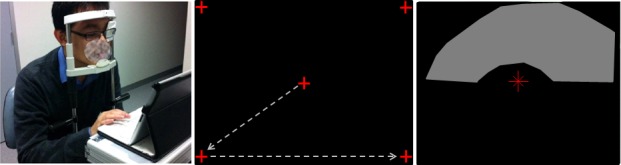
MRF performance was tested in five young participants who had normal vision. (A) The test site with chin and forehead rest and the observer fixating the iPad (at 33 cm) and responding on the keyboard. (B) The five fixation locations that are used sequentially during testing of the central 30° field. (C) A simulated visual field defect shown with a plastic overlay that reduced sensitivity in the superior arcuate region (gray zone).